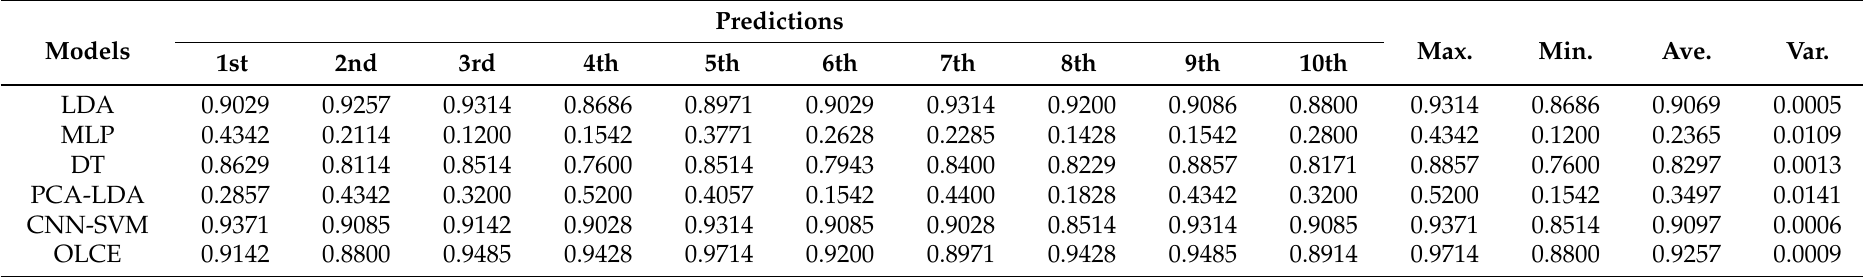
Table 5. Accuracy scores of 6 models (linear discriminant analysis (LDA), multi-layer perception (MLP), decision tree (DT), rinciple component analysis (PCA)+LDA, convolutional